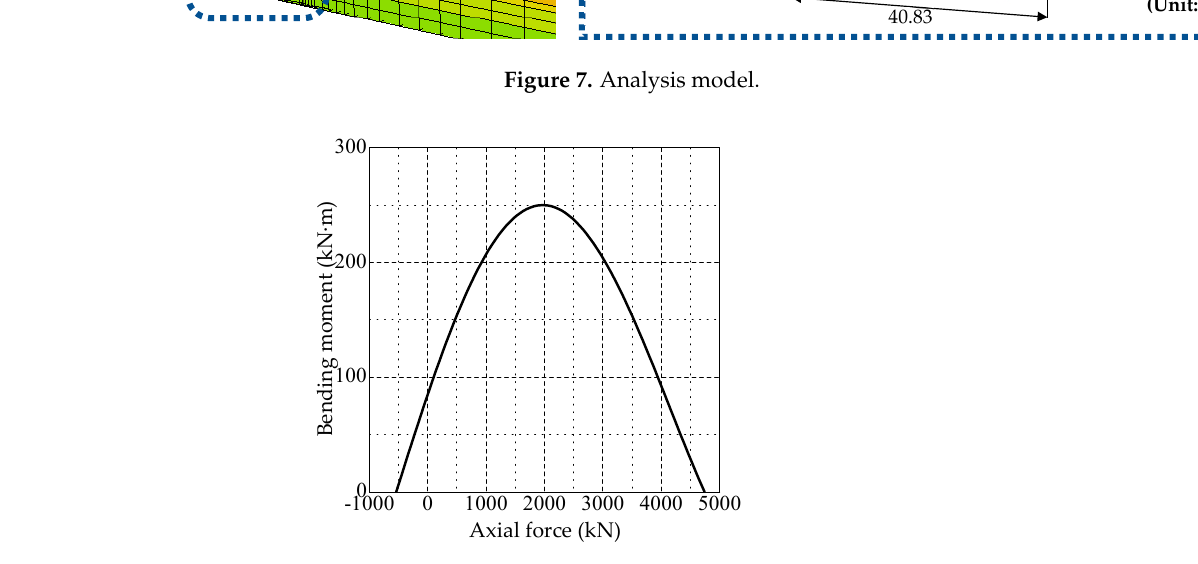
Figure 8. Pile M–N failure diagram.